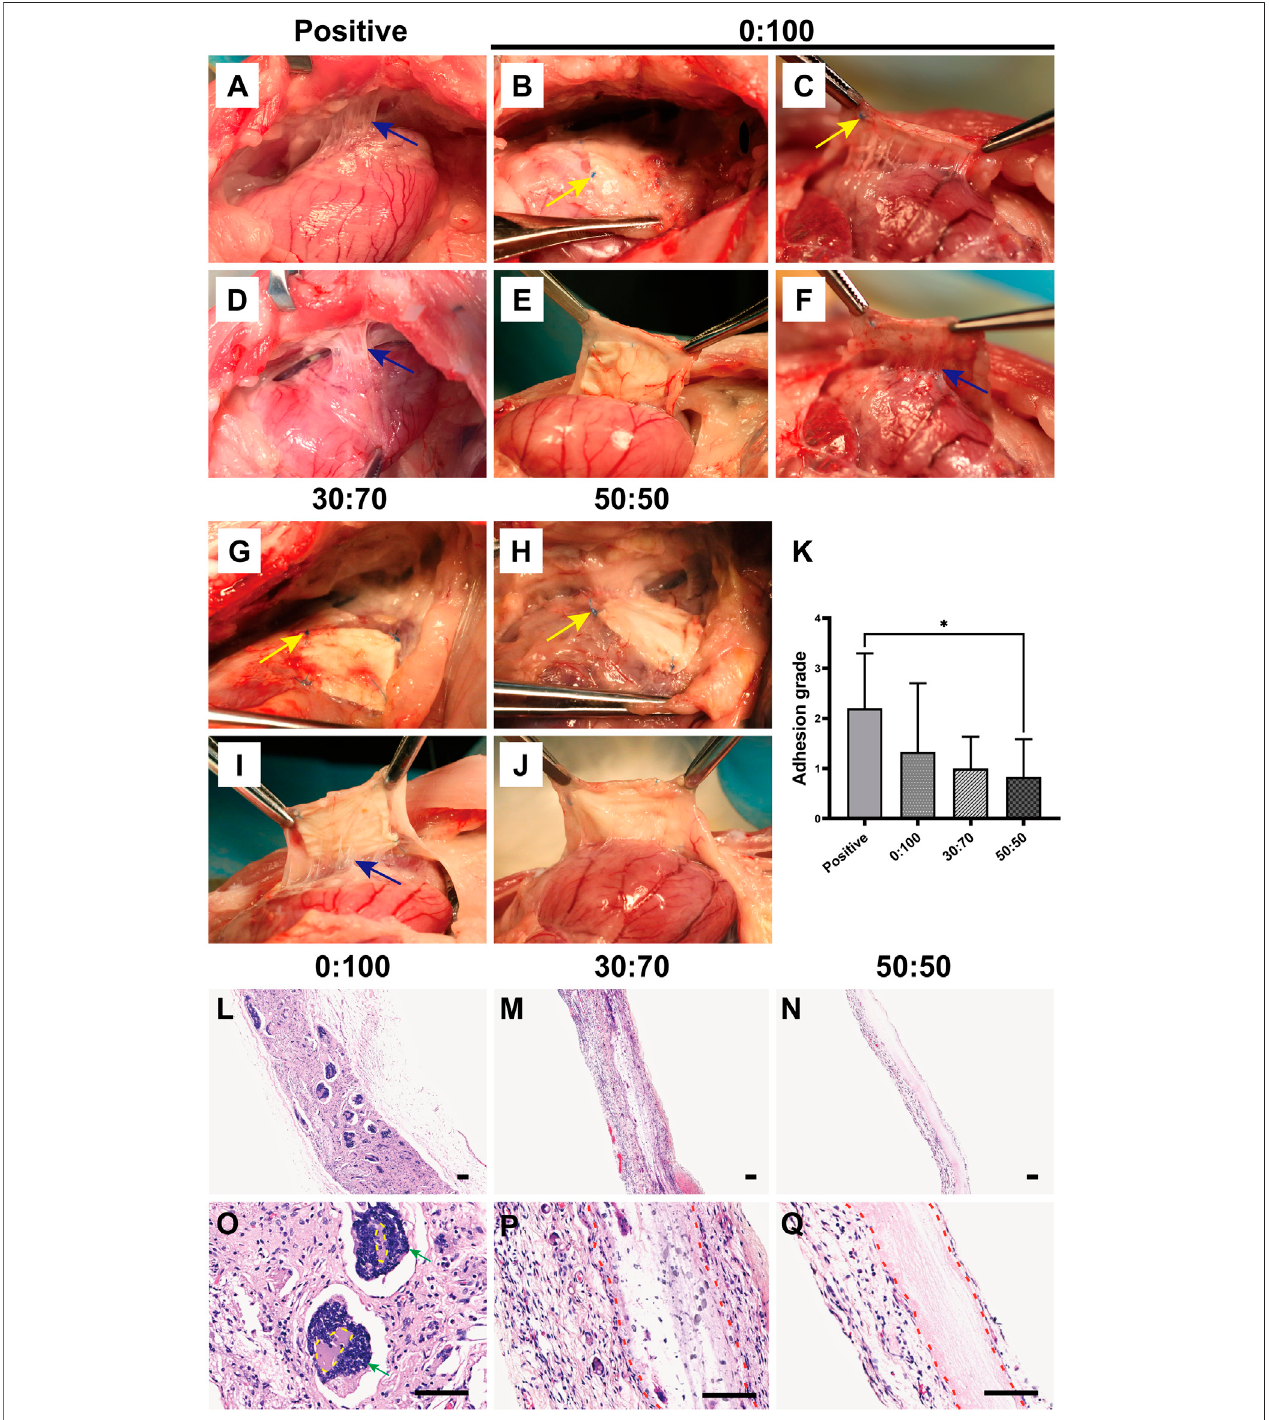
FIGURE 9 | Three months after surgery representative overall images for (A,D) positive control, (B,C,E,F) 0:100, (G,I) 30:70, and (H,J) 50:50 groups, blue arrows indicate adhesion sites, and yellow arrows show sutures positions. (K) Pericardial adhesion grades, * p < 0.05, and representative H-E staining images for (L,O) 0:100, (M,P) 30:70, and (N,Q) 50:50 groups, yellow circles indicate “ islands, ” red dot lines indicate “ barriers, ” green arrows indicate multinucleated giant cells. Scale bars (cid:1) 80 μ m.